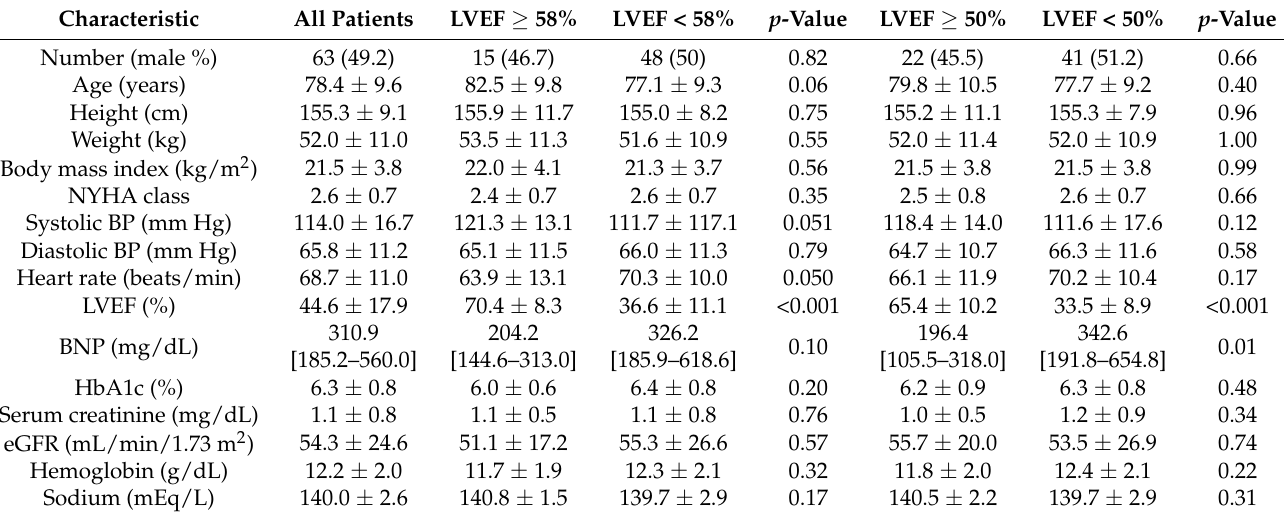
Table 1. Clinical characteristics of study groups at